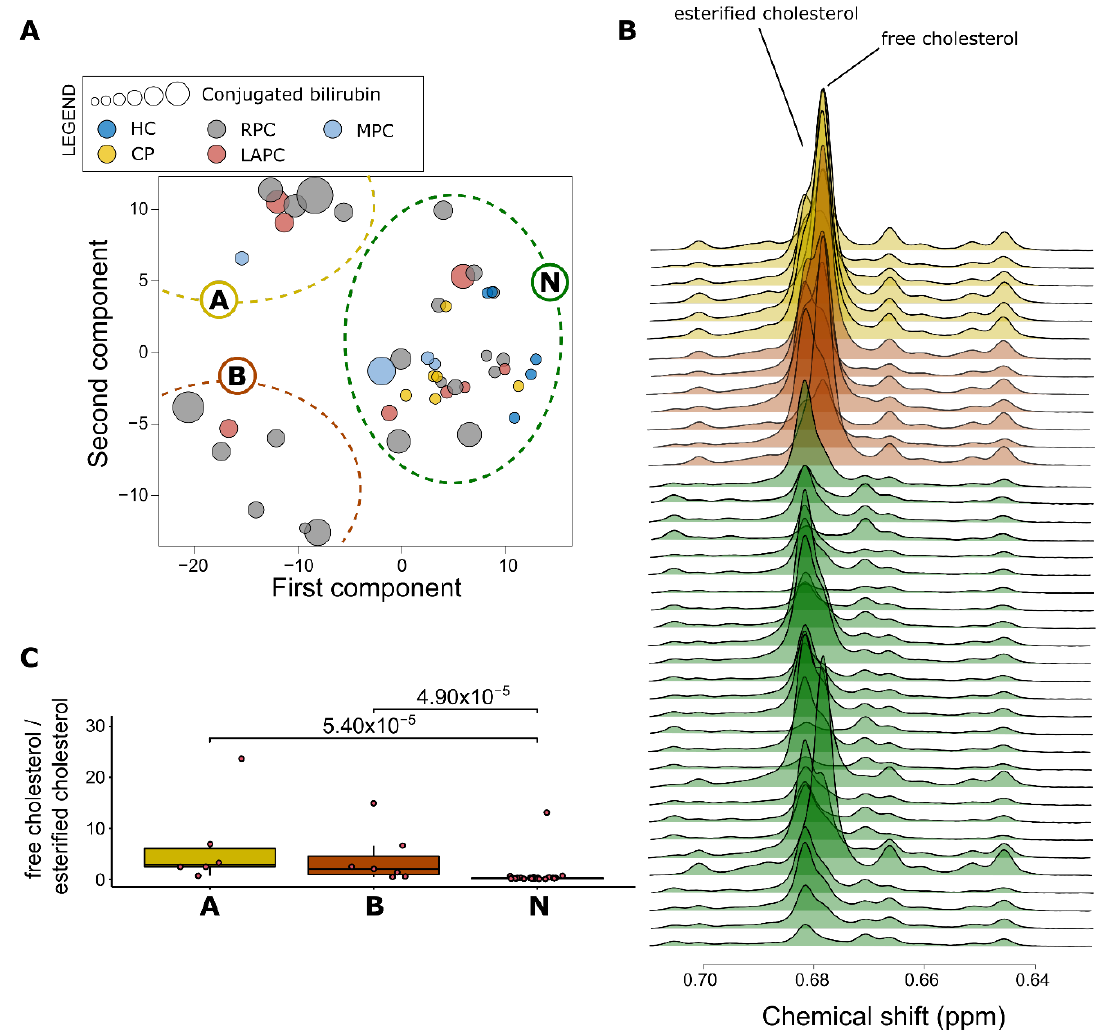
Figure 4. Measurement of Lipoprotein concentration in patient groups. ( A ) Lipoprotein particle concentrations were measured from the NMR spectra using LipoScale test and were separated into 3 clusters. Cluster N, which is made up of all the controls and some PDAC patients, has a normal lipoprotein profile, while clusters A and B have atypical lipoprotein profiles with high bilirubin levels. ( B ) Spectra showing the abnormal lipoprotein profile associated with clusters A (yellow) and B (red) with a high concentration of free cholesterol, which could be indicative of an abnormal lipoprotein profile while cluster N (green) all have a normal lipoprotein profile; higher levels of esterified cholesterol, except for one outlier. ( C ) Boxplot of the ratio of free cholesterol to esterified cholesterol was calculated for the three clusters to comprehend the level of lipoprotein abnormality in the serum. Cluster N has the least ratio. PDAC: Pancreatic Ductal